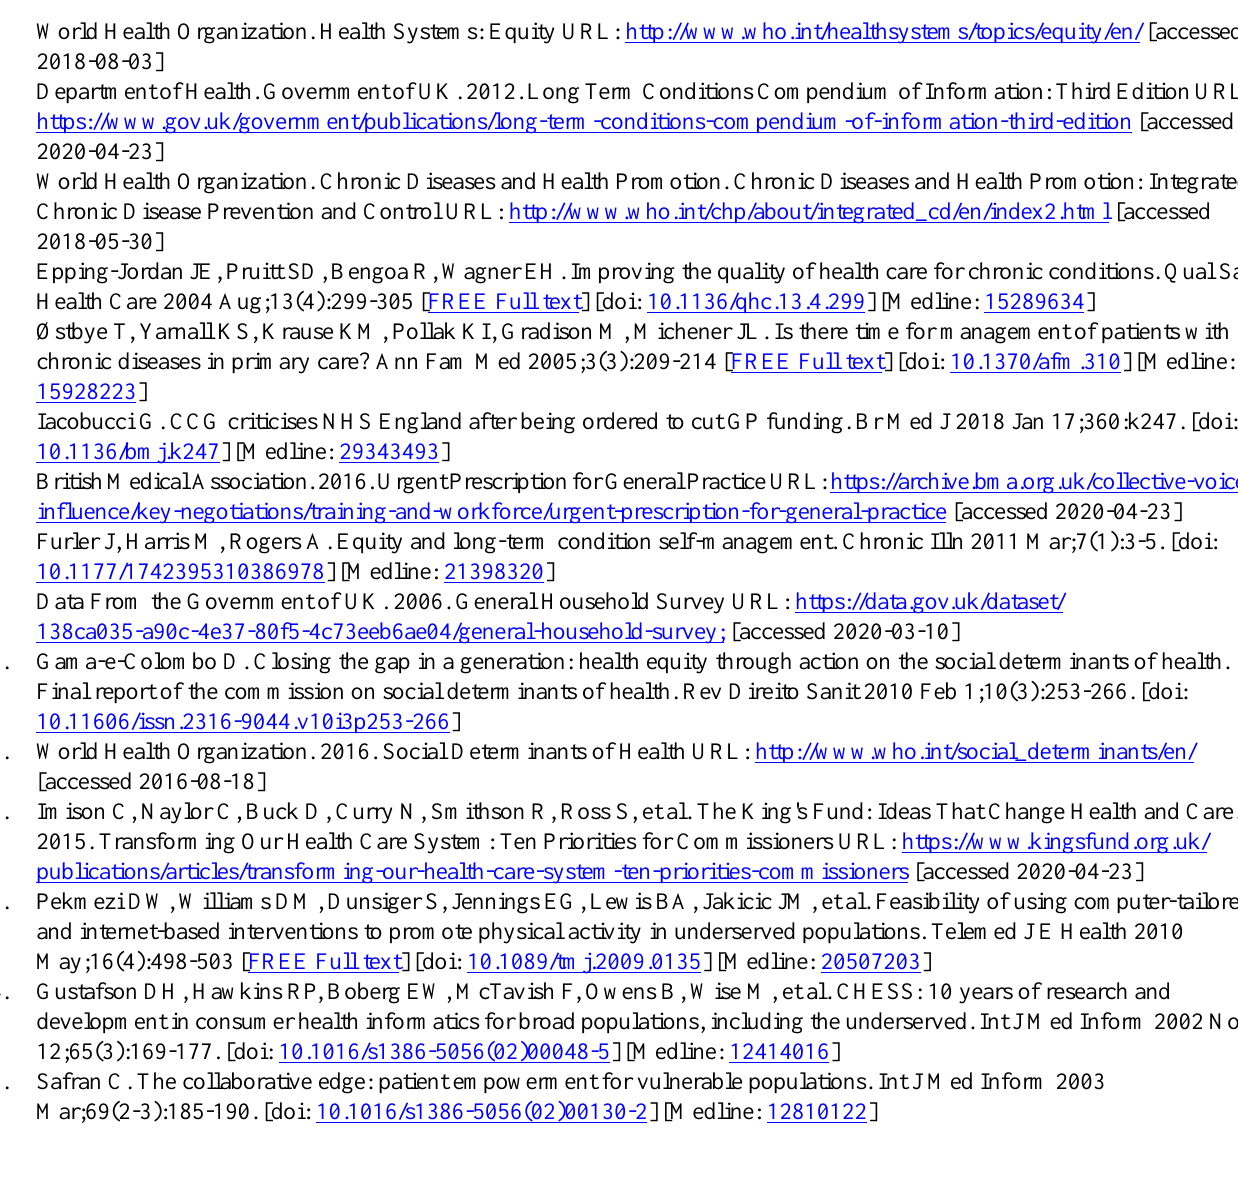
Table 6. Modification of effectiveness data available for PROGRESS-Plus categories in the included